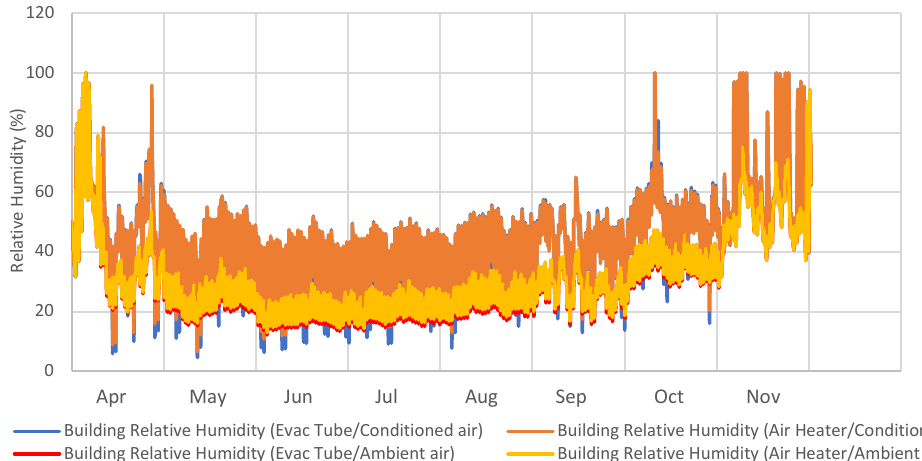
Figure 10. Relative humidity of the air inside the building for both types of systems using either the evacuated tube or air heating solar collector.